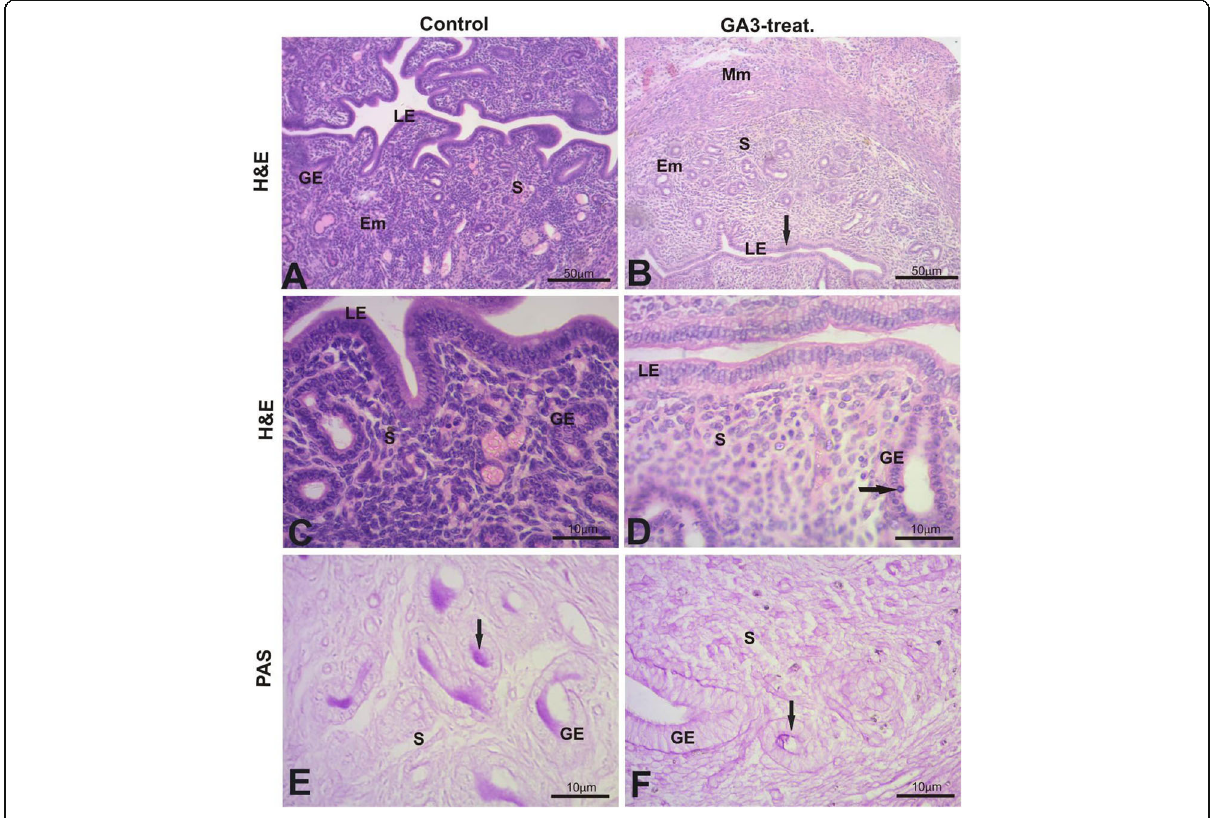
Fig. 1 Photomicrographs of histological sections (H&E and PAS). Control uterus showed normal structure ( a , c ). GA3-treated showed a decrease of uterine folds and an increase of pyknotic cells (arrow, b , d ). Uterine gland of GA3-treated group showed a decrease of PAS content (arrow, f ) as compared to control PAS (arrow, e ). MM, myometrium; EM, endometrium; LE, luminal epithelium; S, stroma; GE, glandular epithelium. Scale bar = 50 μ m ( a , b ) and 10 μ m ( c – e